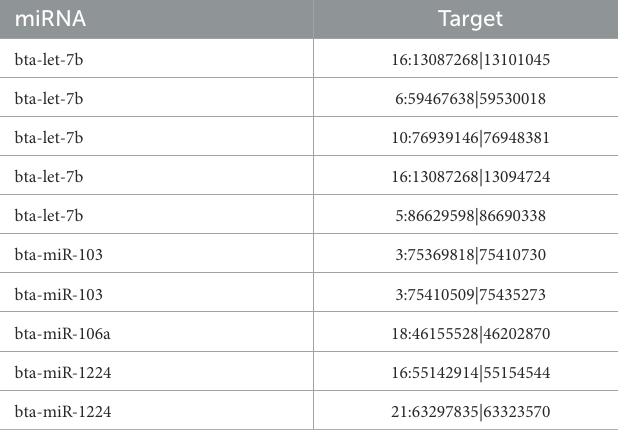
TABLE 9 miRNA target gene information. miRNA